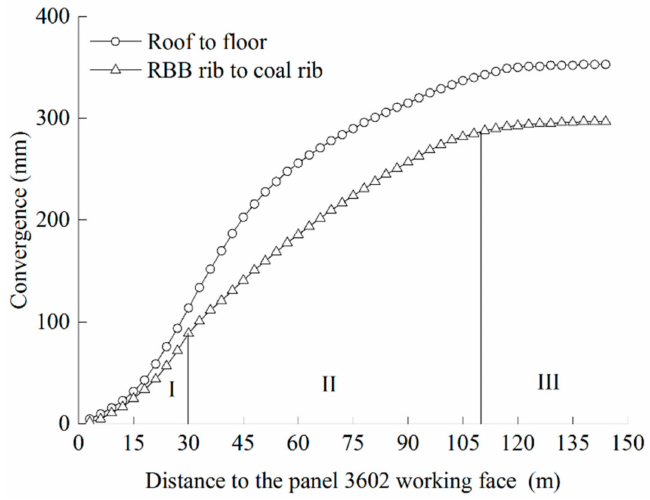
Figure 12. Convergence of